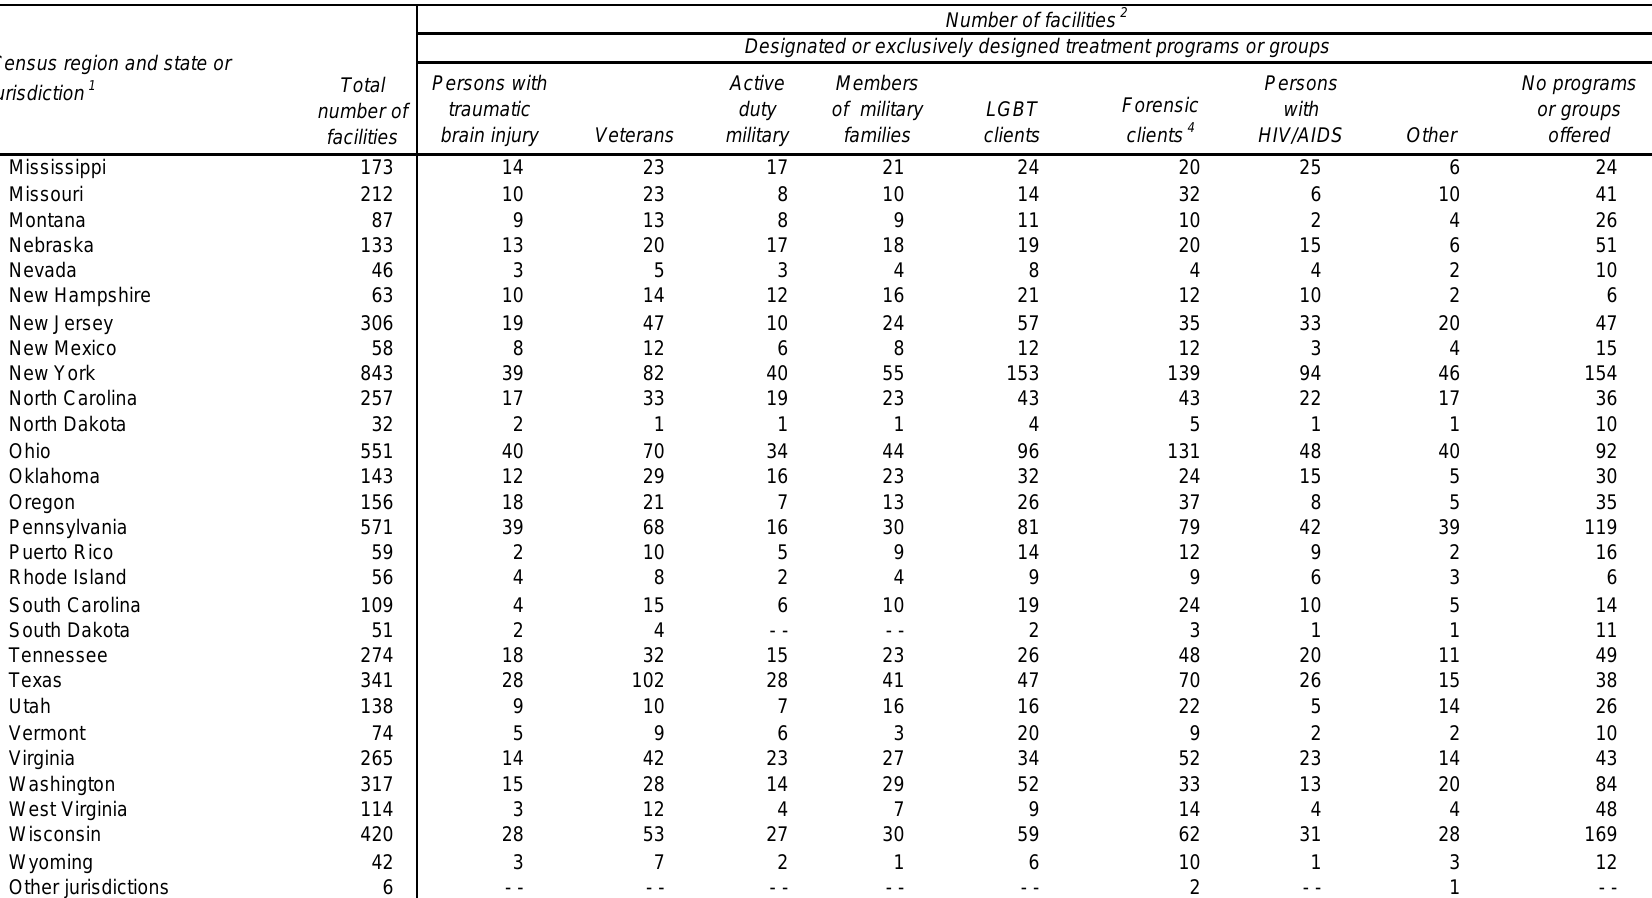
Table 3.10a. Mental health treatment facilities offering treatment programs or groups designated or designed exclusively for specific client categories,